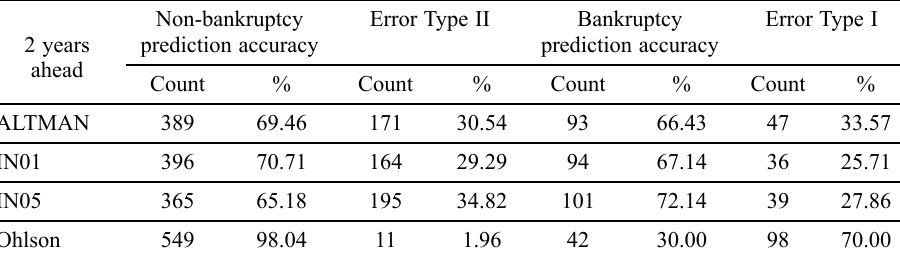
Table 4. Model I validation – two years ahead